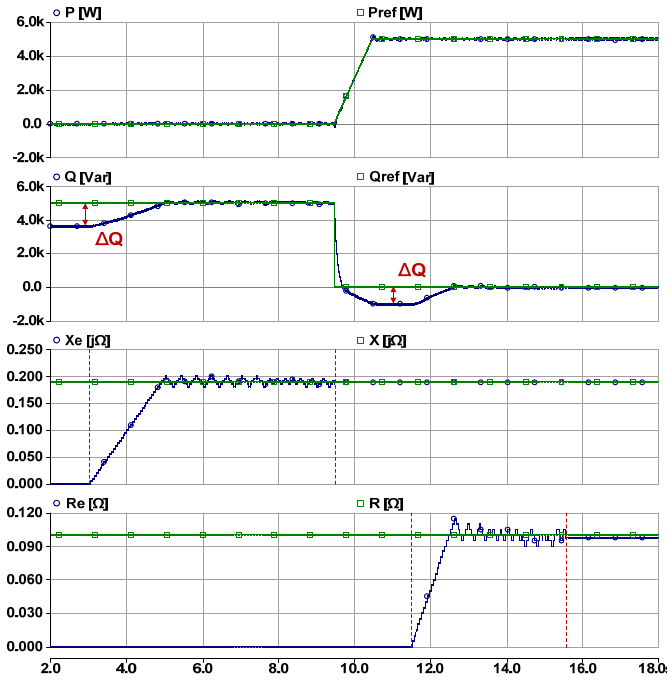
Table 1. Line impedance estimation results.